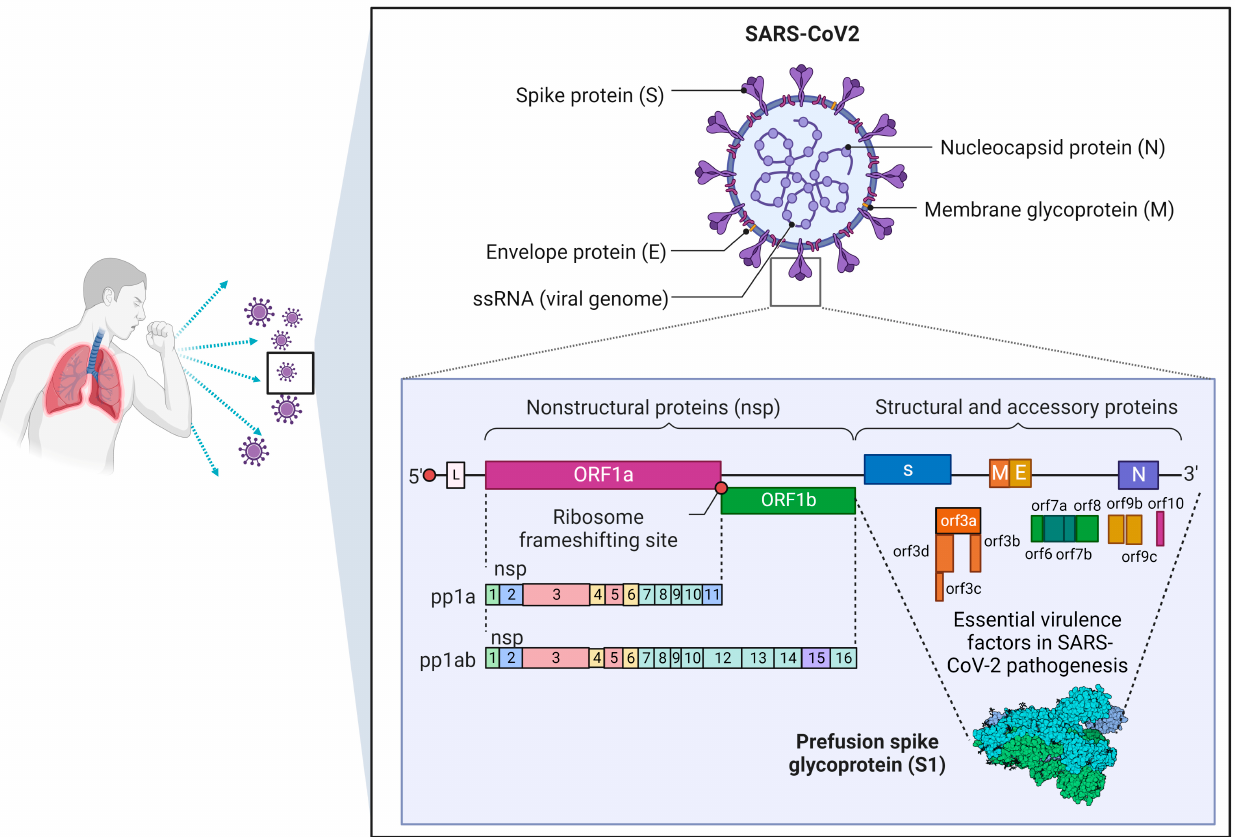
Figure 2. Schematic diagram of the SARS-CoV-2 genome structure. SARS-CoV-2 is spherical in shape. The virus is wrapped in a lipid envelope that is coated with spike glycoprotein. The SARS-CoV-2 genomic organization is characteristic of betacoronaviruses. The full-length RNA genome is roughly 29,903 nucleotides long and contains a 5 ′ UTR replicase complex (composed of ORF1a and ORF1b). ORF1a is responsible for encoding NSP1–NSP10, while ORF1b is responsible for encoding NSP1–NSP16. The structural proteins are encoded by four genes: the spike gene, envelope gene, membrane gene, and nucleocapsid gene, as well as a poly (A) tail at the 3 ′ UTR. Between the structural genes are the accessory